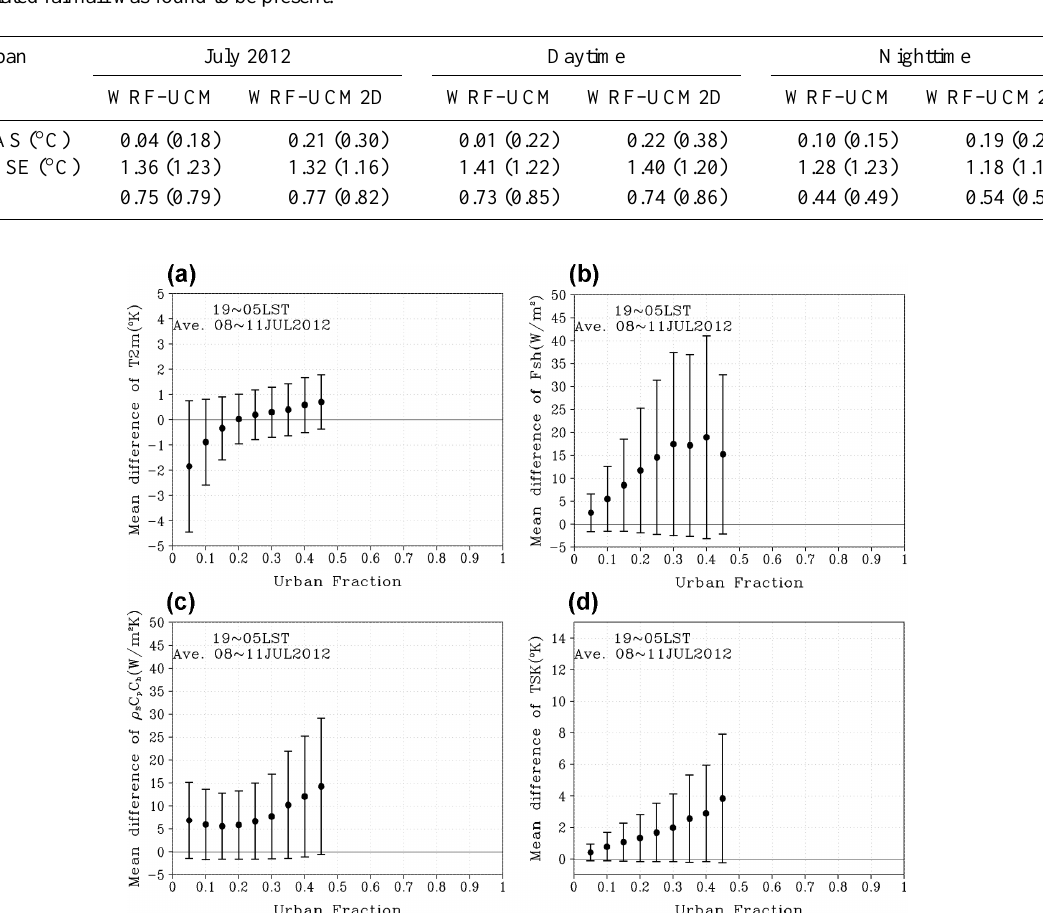
Figure 9. Mean difference in (a) 2m air temperature, T 2m , (b) sensible heat flux, F sh , (c) energy exchange, ρ s C p C h , and (d) ground surface temperature, T sk , simulated by WRF–UCM2D and WRF–UCM at different urban fractions during